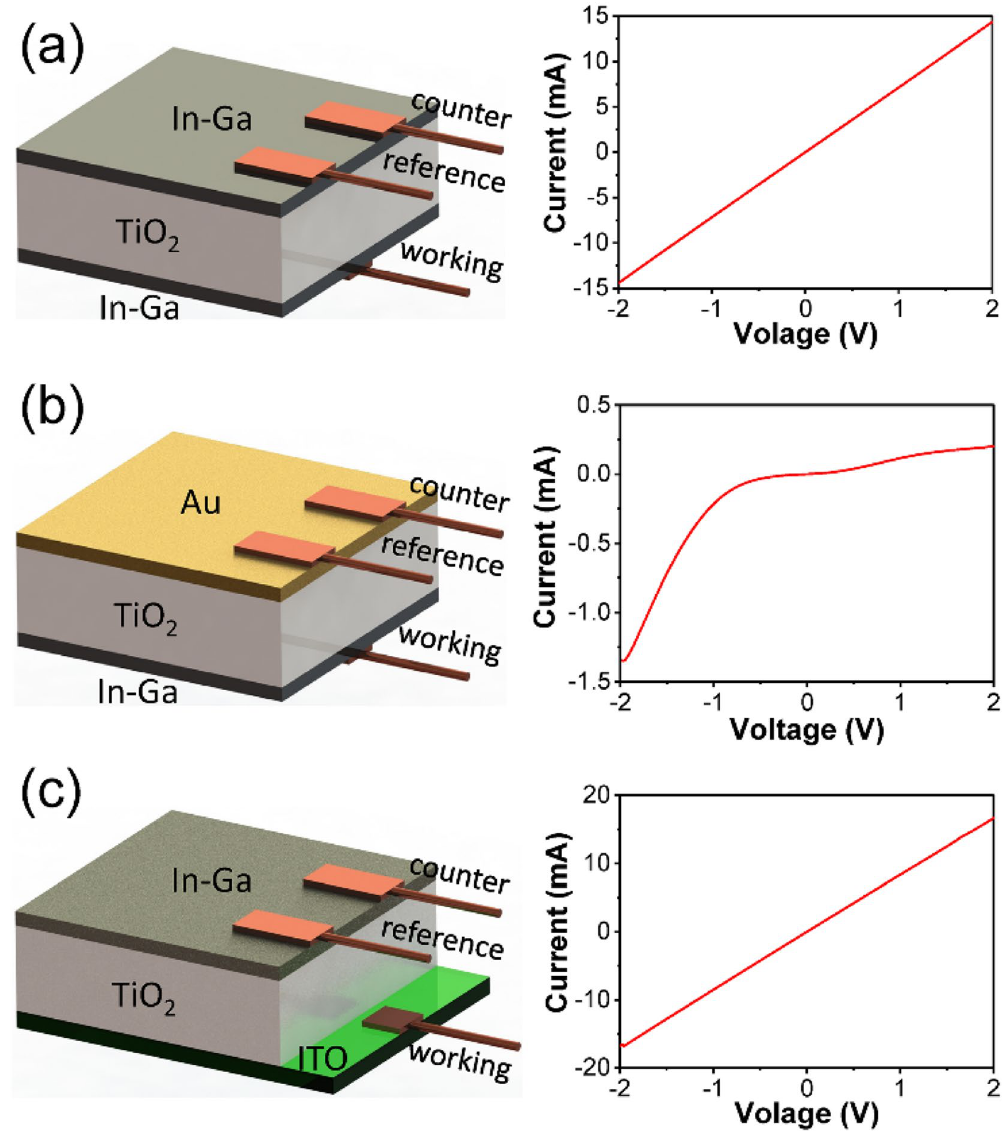
Figure 1. Schematic illustrations of ( a ) In-Ga/TiO 2 /In-Ga, ( b ) Au/TiO 2 /In-Ga and ( c ) In-Ga/TiO 2 /ITO cells (left), and their measured I–V curves